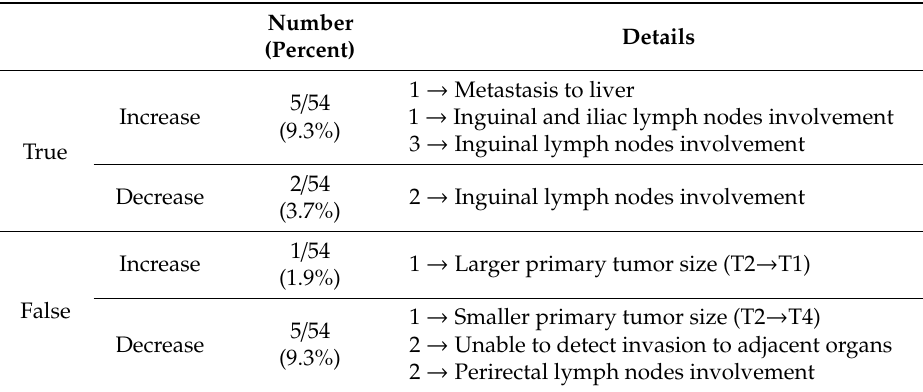
Table 5. Discordant findings regarding the